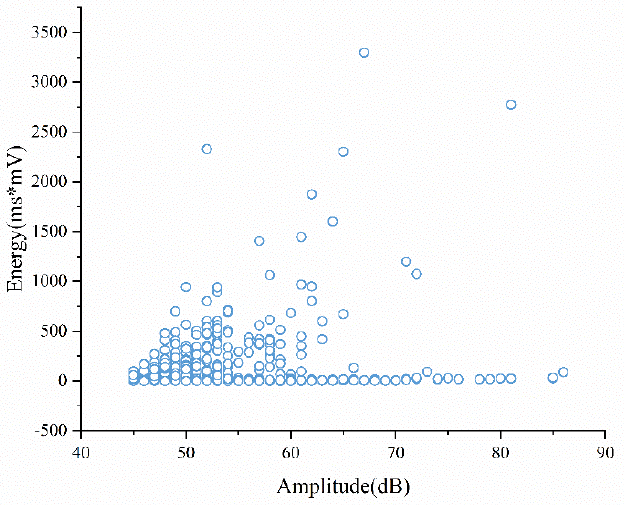
Figure 15. Amplitude-energy correlation diagram of cable noise signal of Yellow River Bridge.